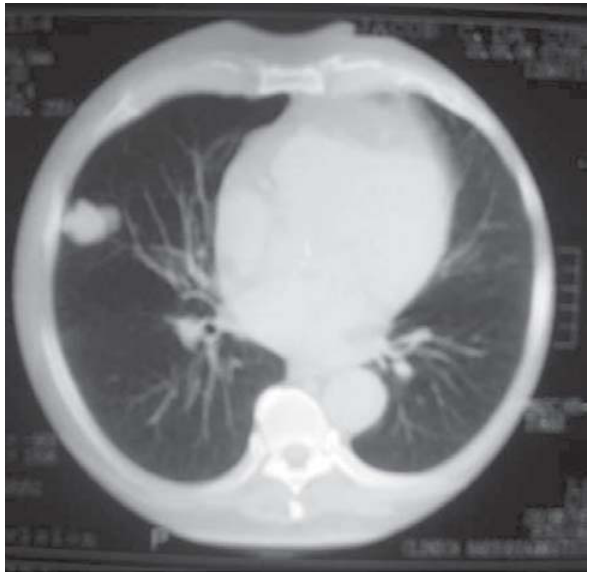
Fig. 2 - Imagem tomográfica do tumor benigno do lobo inferior do pulmão